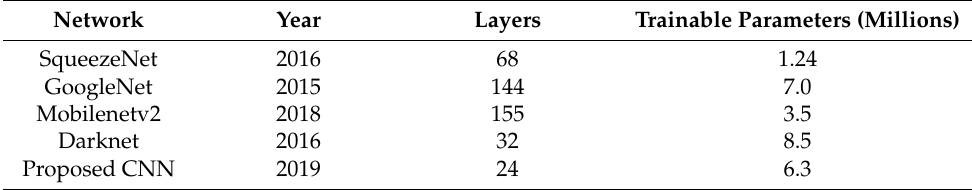
Table 4. Characteristics of CNN networks used in RCNN